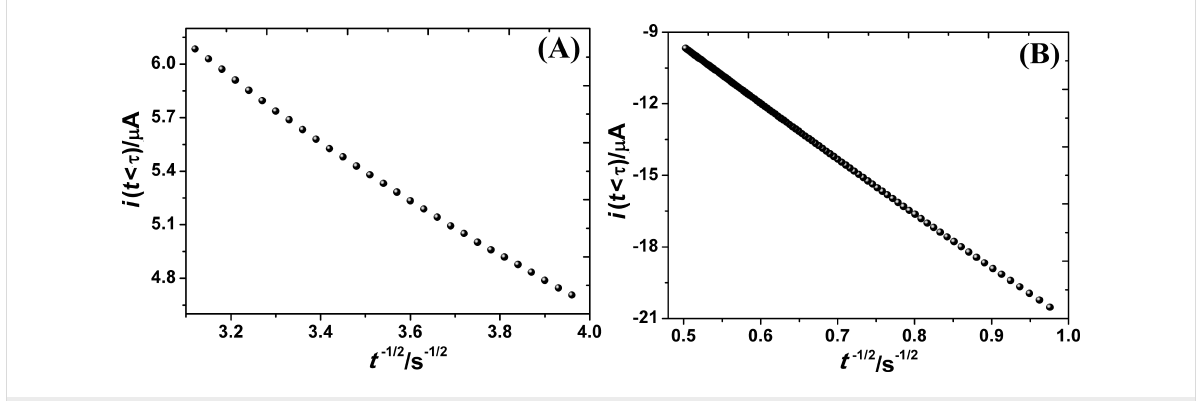
Figure 3: Relationship of i ( t < τ ) vs ( t − 1/2 ) chronoamperometry of 1.0 mM K 3 [Fe(CN) 6 ] in 0.2 M KCl on (A) GCE and (B) PGA/MWCNT/GCE.